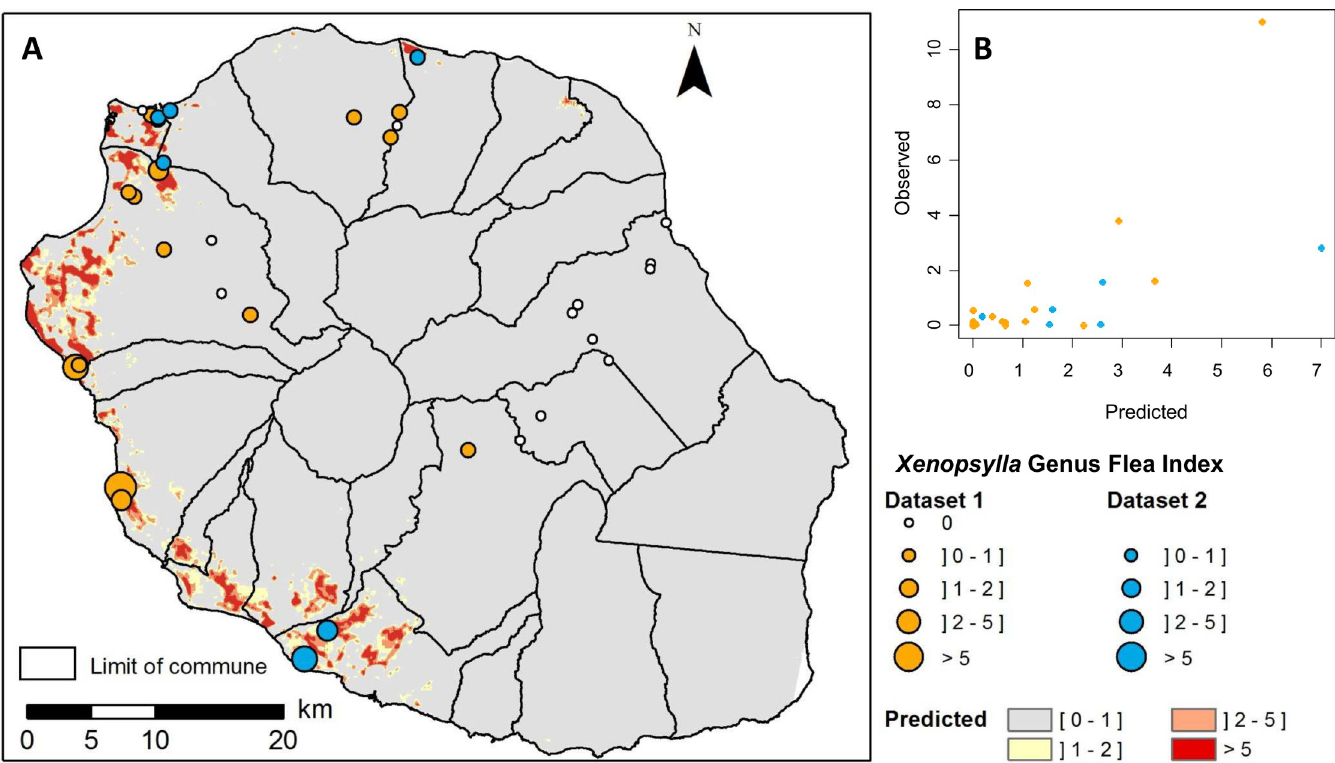
Fig 3. Observed and predicted Xenopsylla Genus Flea Index (GFI) in Reunion Island. A) Map of predicted GFI based on climatic and environmental variables (source for the administrative limits: French national geographic institute BD TOPO–data available under the free license Open license 2.0) B) Bi-dimensional representation of predicted and observed GFI values. Observed GFI values from dataset 1 and dataset 2 are plotted in orange and blue colors, respectively.